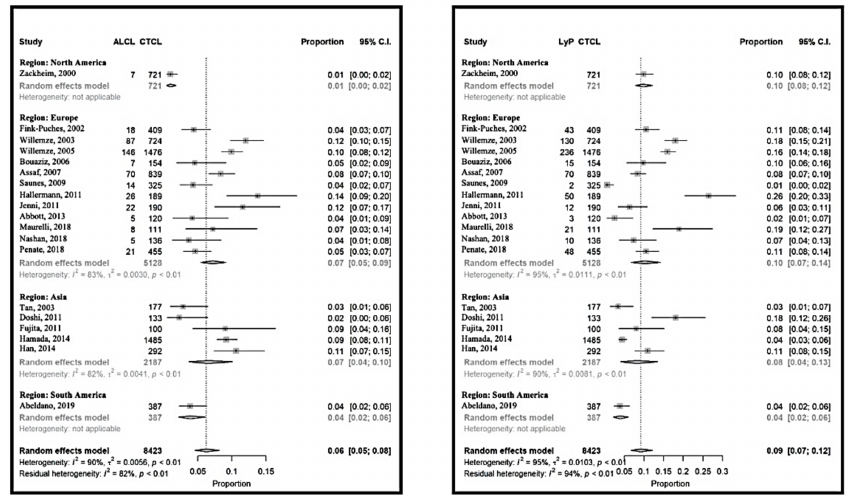
Figure 4. Meta-analyses of the proportions of CD30 + lymphoproliferative disorder subtypes, primary cutaneous anaplastic large cell lymphoma (ALCL) and lymphomatoid papulosis (LyP) compared to CTCL.